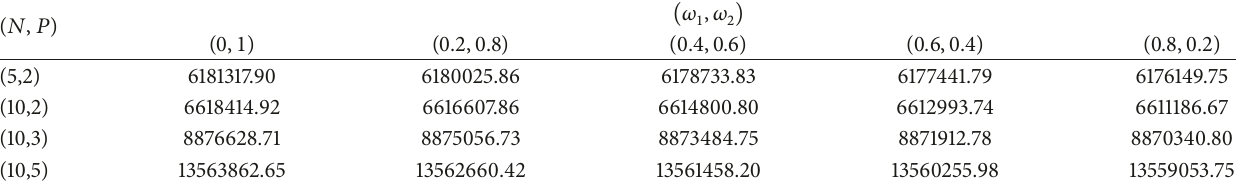
Table 2: Computational results obtained when solving the hybrid